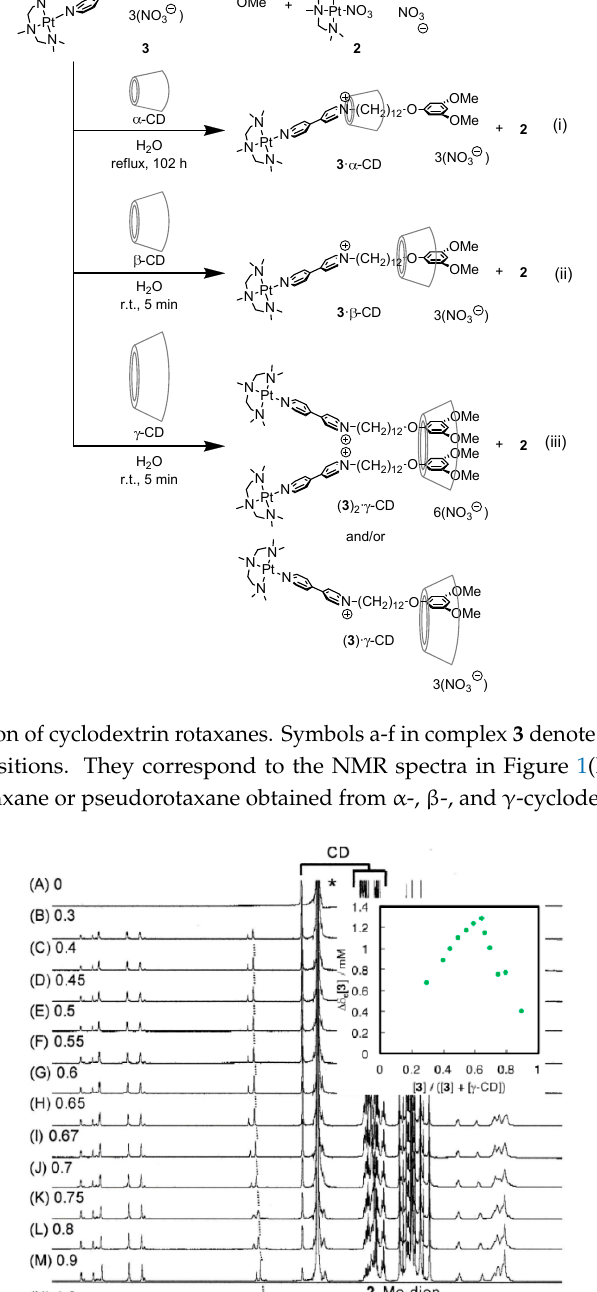
Figure 3. 1 H-NMR spectra with the rotating-frame Overhauser effect (ROE) difference mode. ( a ) [ 3 ] 3+ (6.0 mM) + [ 2 ] + (12.0 mM). ( b ) [ 3 ] 3+ (6.0 mM) + [ 2 ] + (12.0 mM) + γ -CD (30.0 mM). More information on the relative positions of the axle molecules and cyclodextrins was obtained by two-dimensional rotating frame Overhauser effect spectroscopy (ROESY) NMR spectroscopy experiments; the results are shown in Figures 4 and 5.